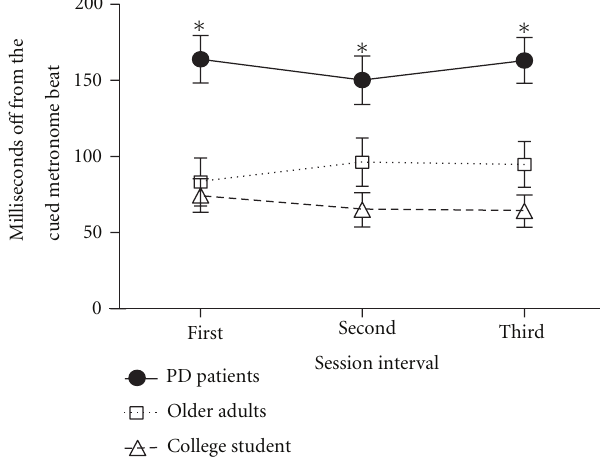
Figure 1: Motor timing performance (average of milliseconds o ff from the cued sound) for the first, second, and third sessions on the Groove for college students (open triangle), older control adults (open square), and Parkinson patients (filled circle). ∗ P < . 05 compared to college